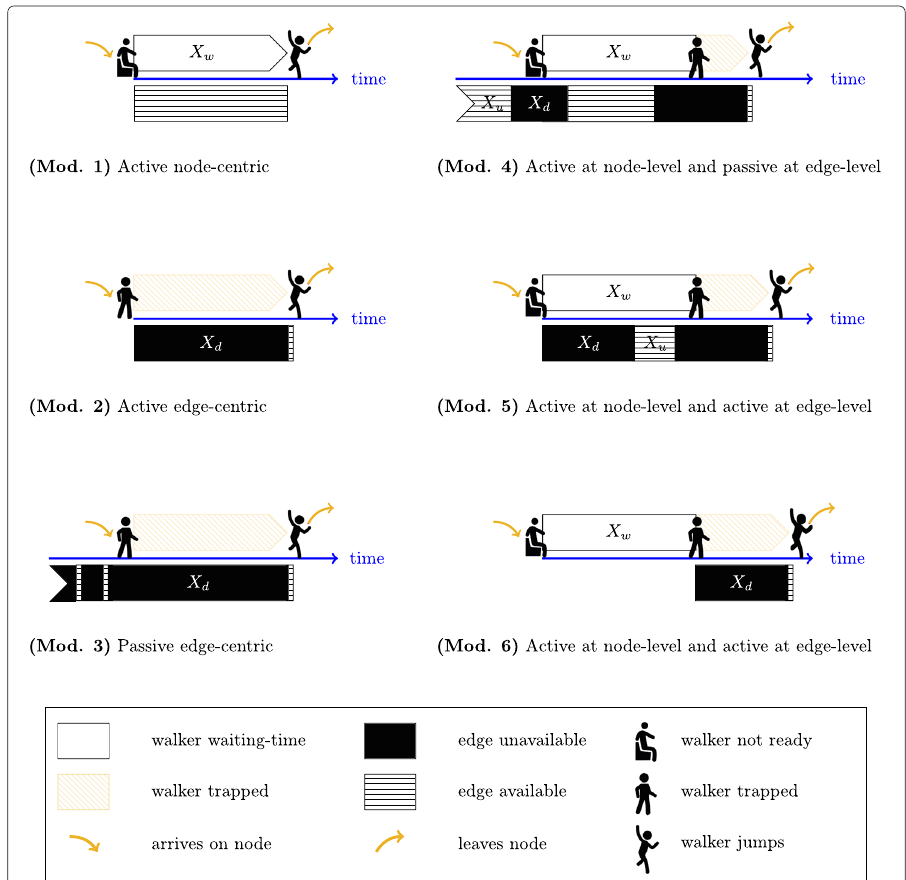
Fig. 1 Random walk models. Each of the six panels represents a random walk model. In each case, the ribbon above the blue time axis represents the dynamics at node level, that is, the waiting time X w of the walker, possibly extended by a period where the walker is trapped. The ribbon under the time axis represents the dynamics at edge-level, with the associated random variables X u and X d for the up-times and down-times respectively. In the left column, the three classical models with only one timescale are represented, whereas in the right column, the walks have two (model 6) or three (models 4 and 5) competing timescales. For each model, the arrival time on the node is located on the time axis by the leftmost man icon (standing or sitting), and the time of the jump corresponds to the rightmost jumping-man icon. When the node-level ribbon (above the blue axis) and the edge-level ribbon (below the blue axis) have a synchronous start from the left, as in models 1, 2 and 5, the walk is fully active. Model 6 is also fully active, even though the reset of the edges happens after a term X w . On the other hand, models 3 and 4 are passive at edge-level. This means that the edges dynamics is independent of the walker, in the sense that the arrival of the walker on a node does